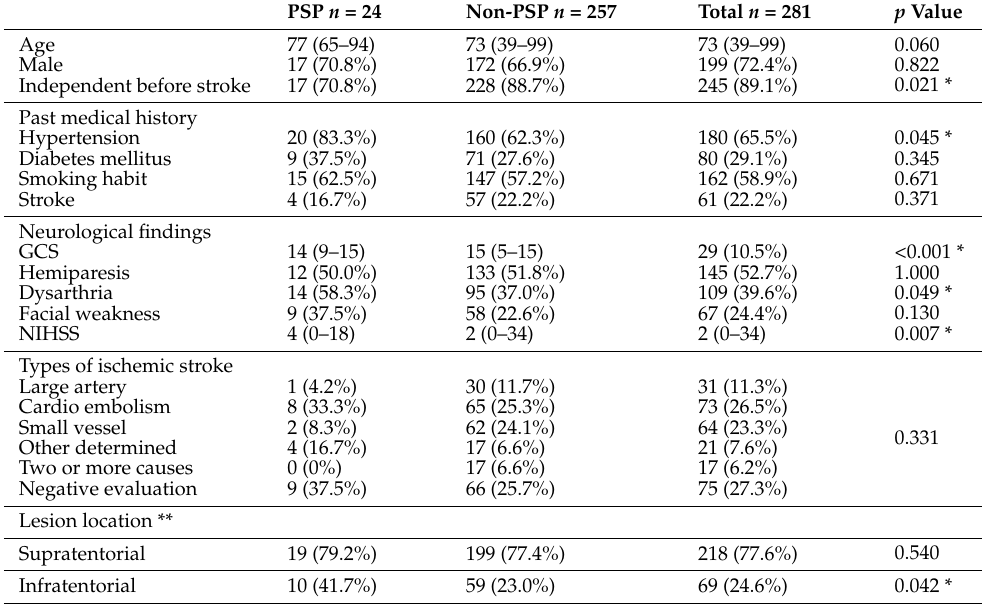
Table 1. Characteristics of PSP and non-PSP